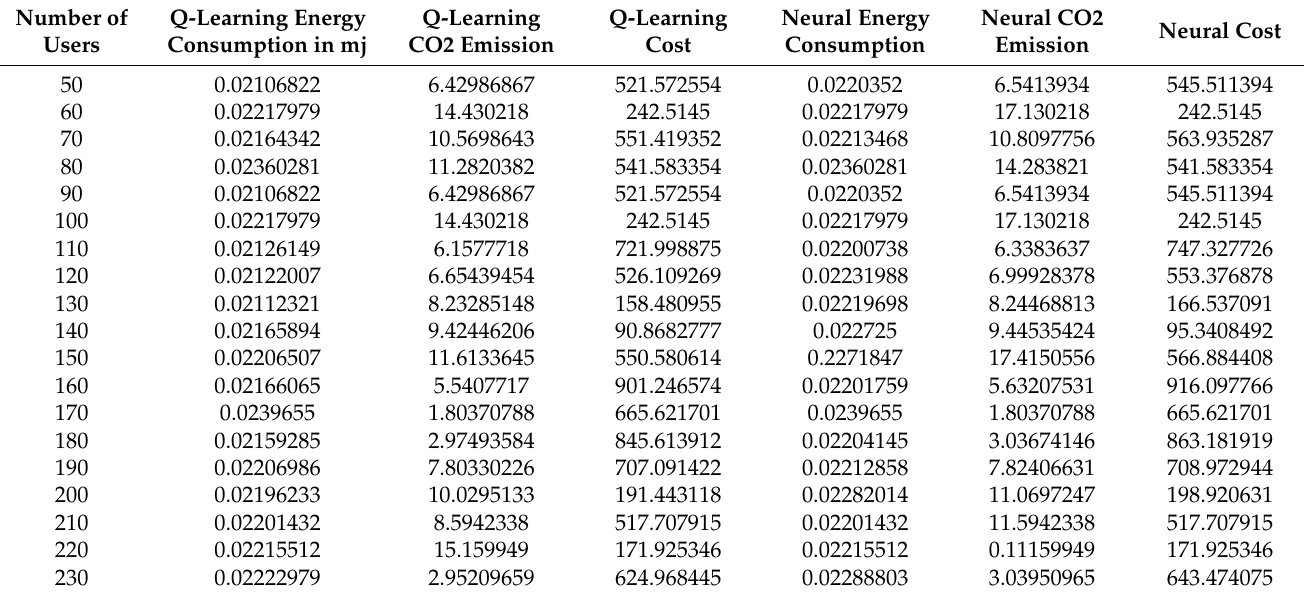
Table 2. Result illustration for variation in user